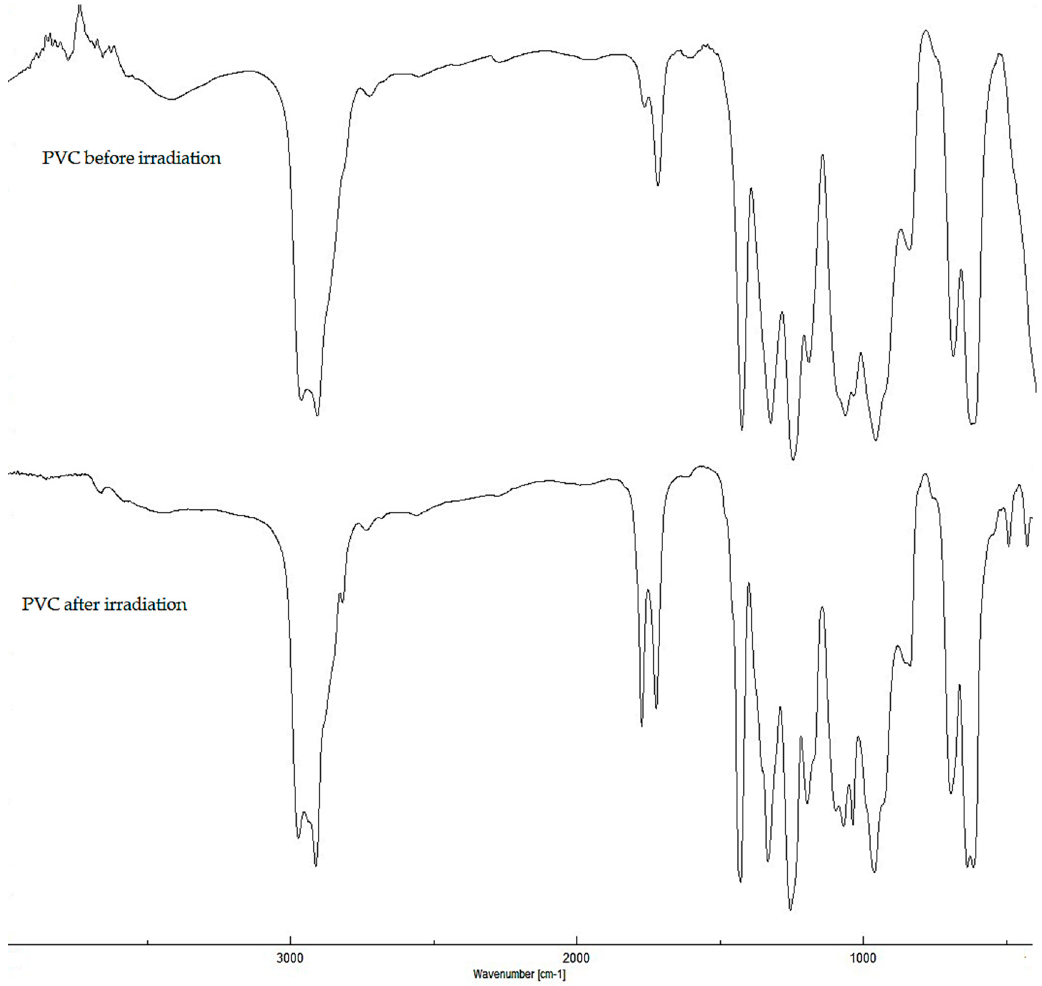
Figure 2. FT-IR spectrum of poly(vinyl chloride) (PVC) films before and after irradiation.